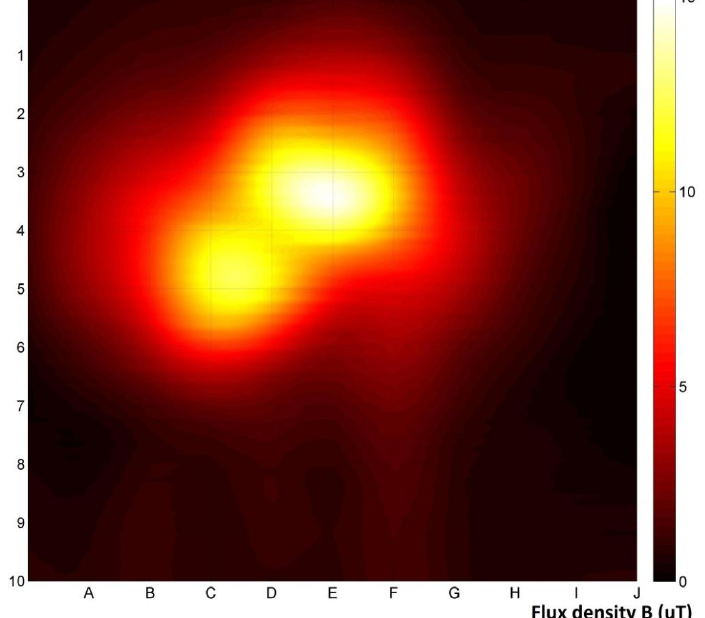
Figure 6. Differential bi-plane measurement within 100 mm of the